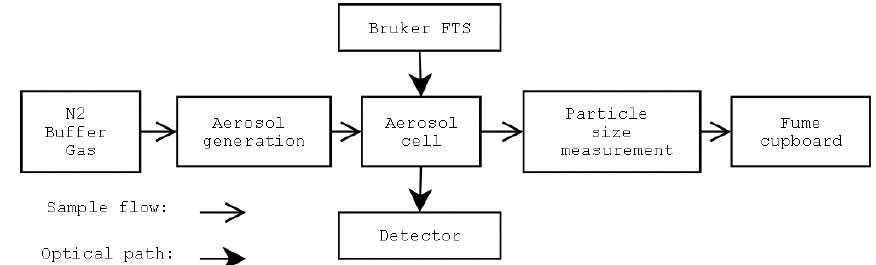
Figure B1. Simplified schematic of the experiment.